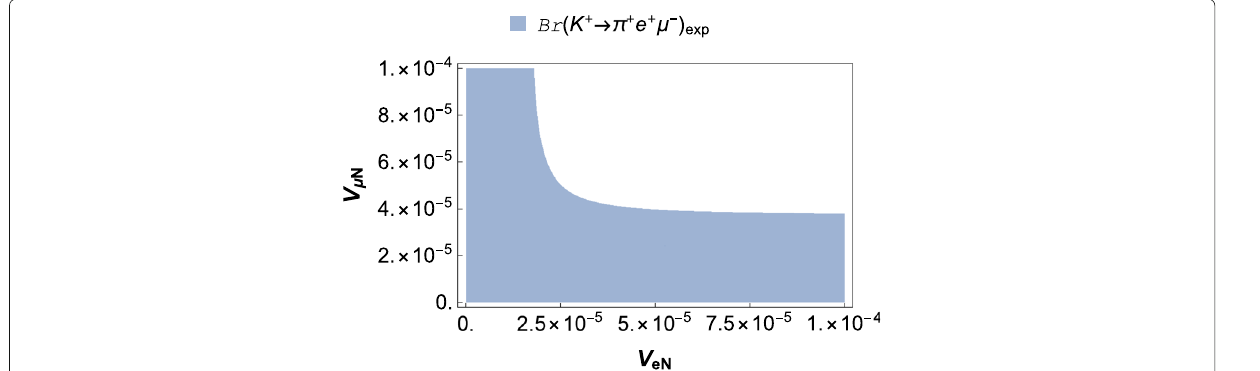
Fig. 4 The allowed parameter space in scenario A, in which we have taken m N = 0.3GeV as an